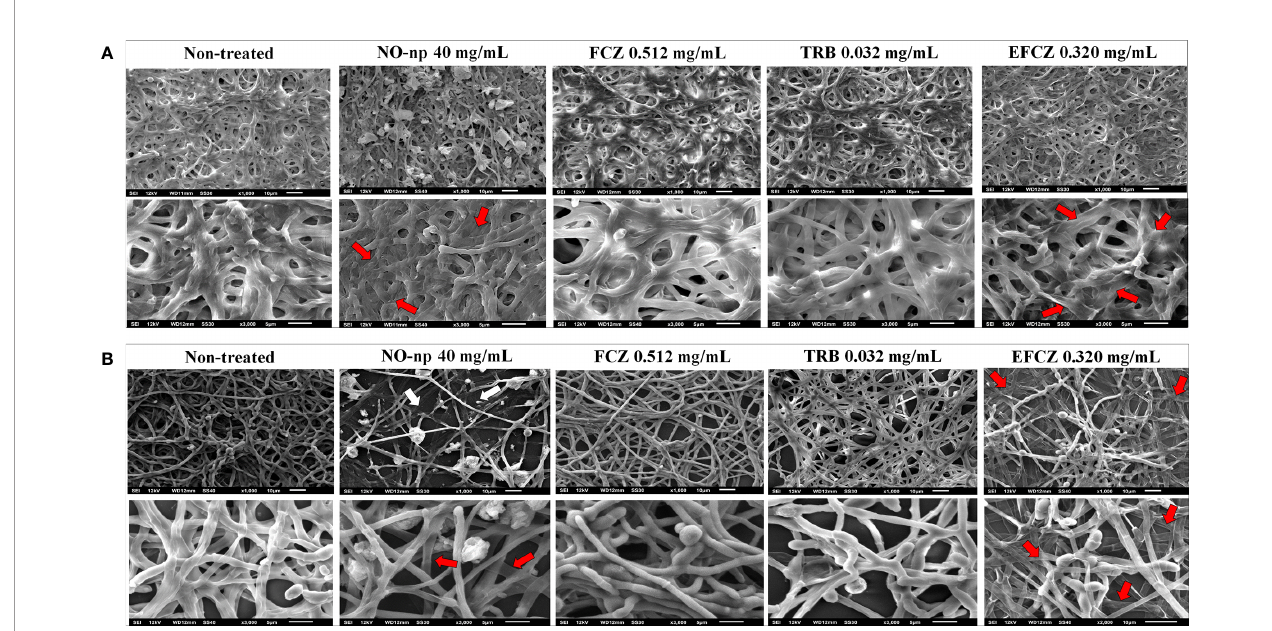
FIGURE 2 | Scanning electron microscopy showing the architecture of bio fi lms for (A) T. rubrum ATCC MYA-4438 and (B) BR1A strains. Different magni fi cations (upper panel; 1000 and lower panel; 3000X) are shown for untreated bio fi lms and those treated with NO-np 40 mg/mL, fl uconazole (FCZ) 0.512 mg/mL, terbina fi ne (TRB) 0.032 mg/mL, or e fi naconazole (EFCZ) 0.320 mg/mL. Red arrows denote collapse of the hyphal walls, while white arrows denote reduced hyphal density.